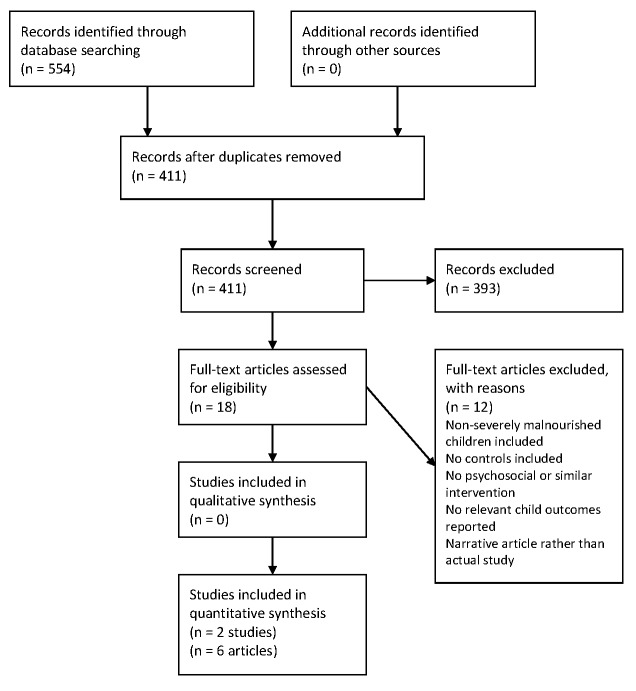
Study flow diagram.